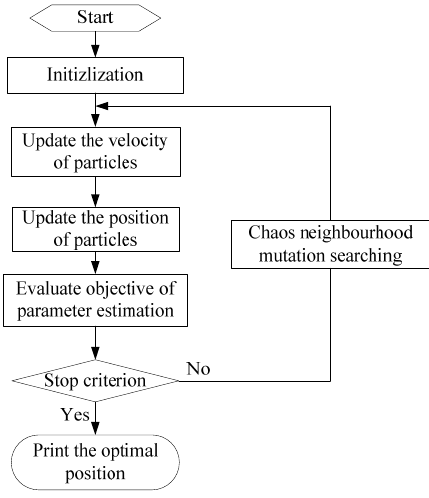
Figure 3. Chart of Improved Particle Swarm Optimization (IPSO)-based parameter estimation. (1) Initialization : From Section 2, there are 13 parameters, L , p and q for the optimal parameter of the microgrid model. The initial r , L , T , drl u u qr qrl j particles may be generated randomly with a specified upper and lower bounds, respectively. The dimension of each particle is equal to the number of the parameters. Measured data u ju ) and powers ( P jQ ) of PCC. include voltages ( x y